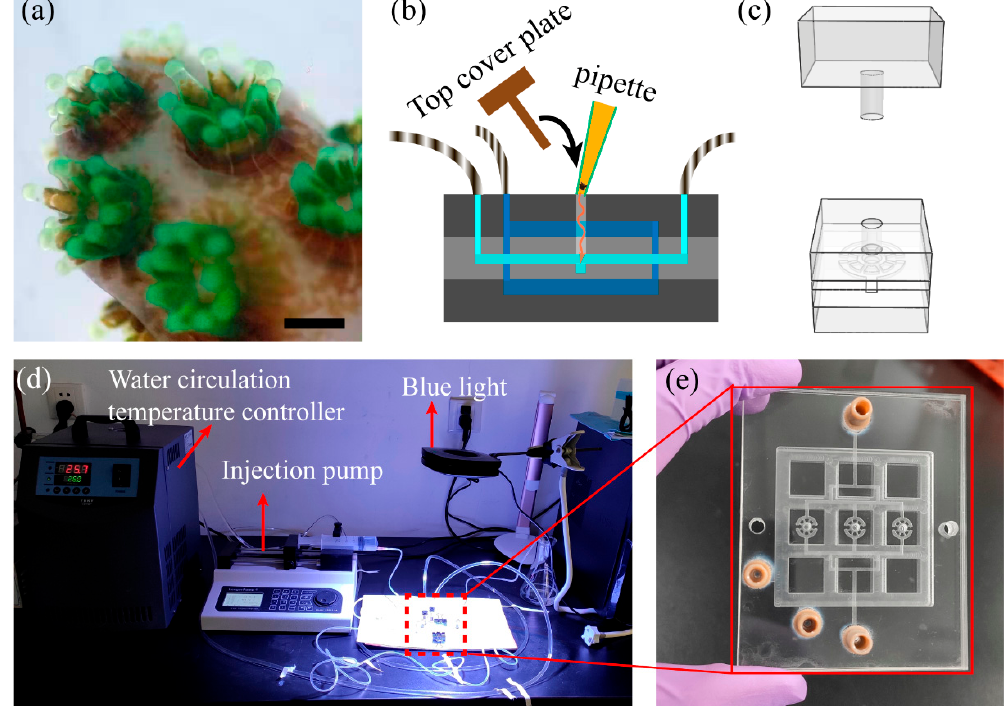
Figure 4. Explantation and culture of individual coral polyps. ( a ) Fluroscence images of the fast-growing apical fragments during the bail-out process (scale bar = 1 mm). ( b ) Schematic image illustrating the coral polyp explantation and assembly process. ( c ) Layout of the polyp culture cell. ( d ) Experimental setup for culturing individual coral polyps in the microfluidic device. ( e ) Photograph of a microfluidic chip.